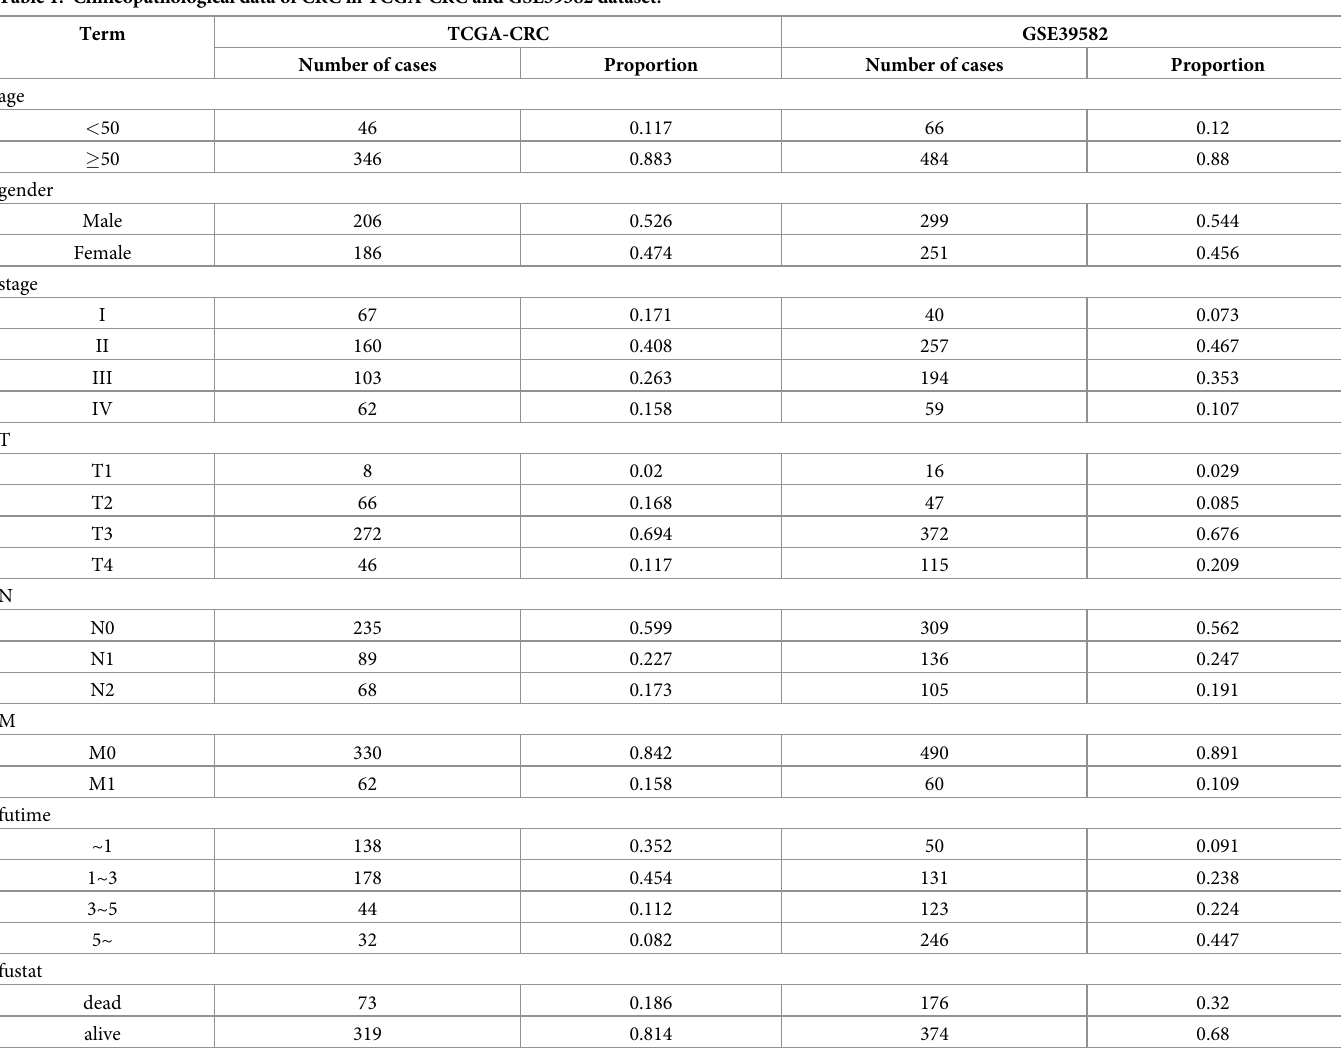
Table 1. Clinicopathological data of CRC in TCGA-CRC and GSE39582